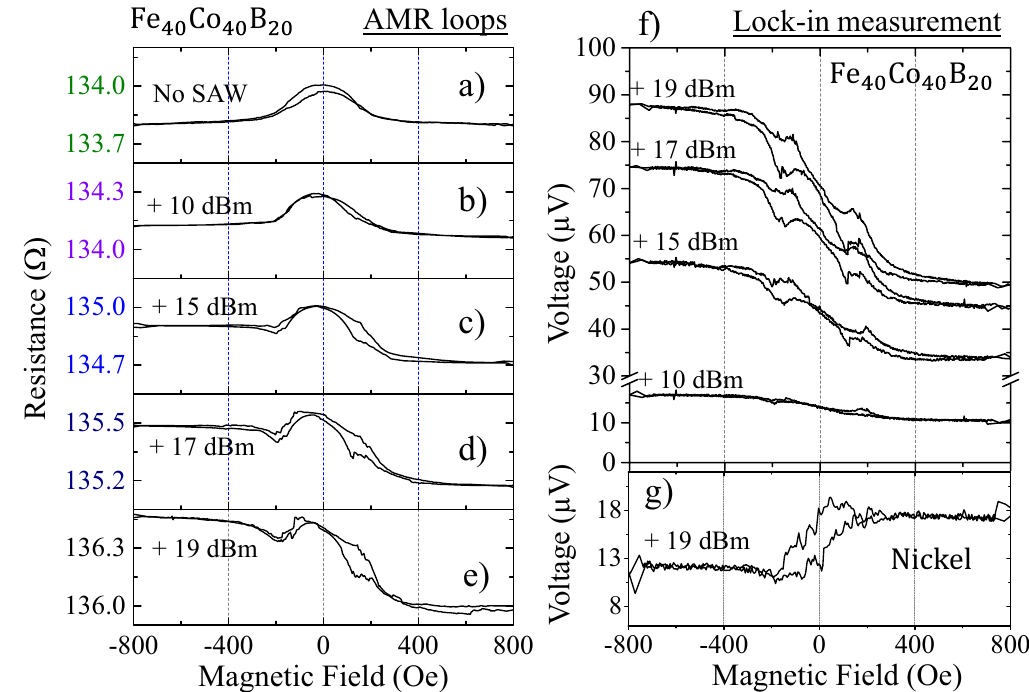
Figure 5. ( a – e ) AMR loops in the FeCoB nanostrip with the field applied in the y -axis (see Fig. 1a), for increasing power of the SAW as indicated. The loops are measured with de DC current of − 100 µA following the geometry displayed in Fig. 1a. Note the increase in the total resistance when the power of the SAW increases and the large asymmetry generated for large power of the SAW. ( f ) Shows the lock-in measurement in the FeCoB nanostrip following the set-up described in Fig. 3a but with the external field applied along the y -axis. ( g ) Shows the lock-in measurement in the Ni nanostripe with the external field along the y-axis (see complete set of measurements in Suppl. Info.